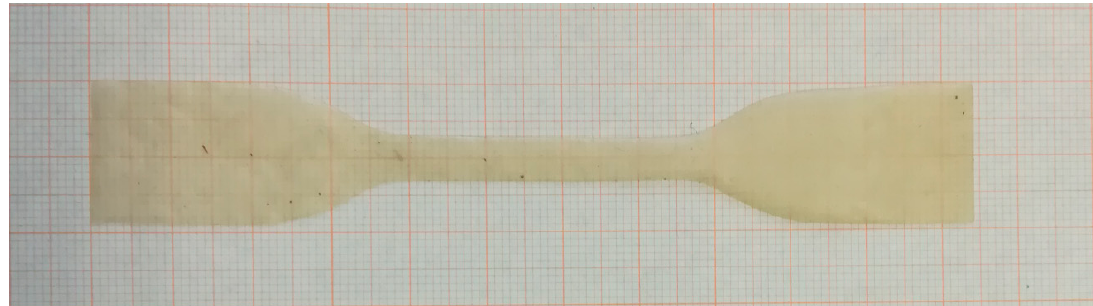
Figure 4. Typical dog bone dimensions (in the image a barely macerated (MA) film sample is shown as an